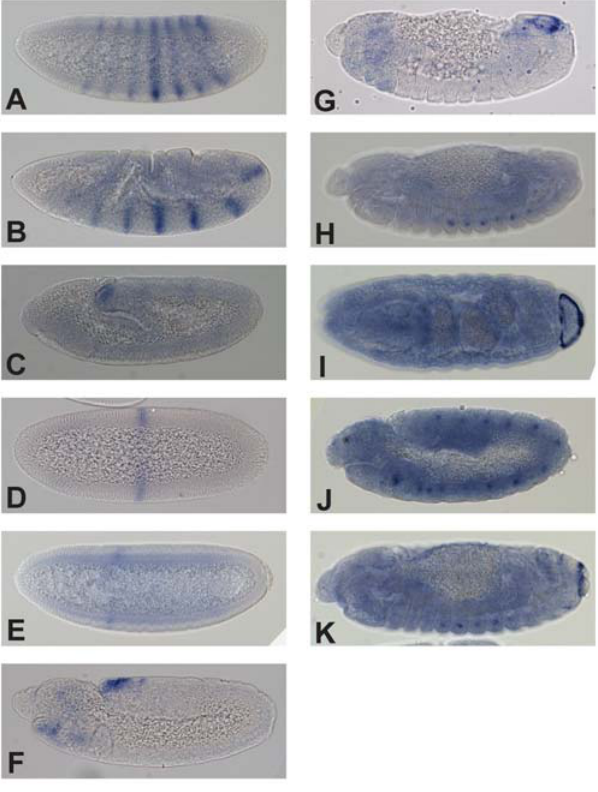
Figure 7. Expression patterns driven by tested eve fragments. Expression of reporter transcript in transgenic D. melanogaster embryos expressing either CFP or lacZ under the control of C. capitata conserved fragments and the naı¨ve D. melanogaster eve basal promoter were visualized by in situ hybridization with digoxigenin-labeled antisense RNA probes. We tested all 9 fragments labeled in Figure 4. A–C)